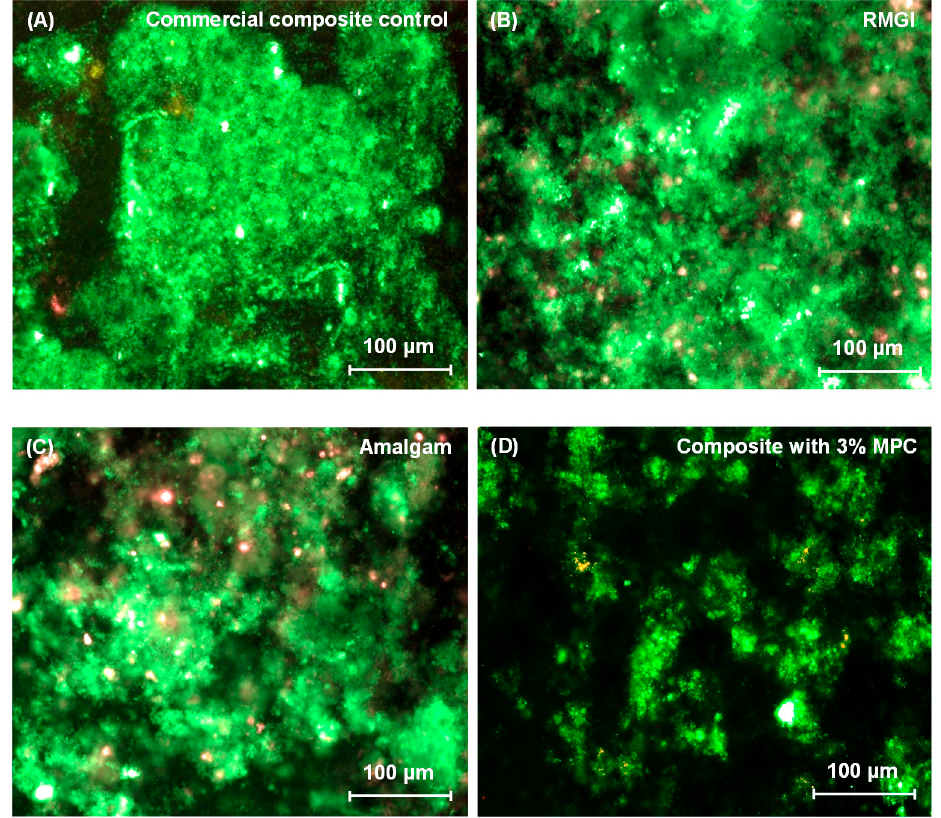
Figure 2. Representative live/dead staining images of dental plaque microcosm biofilms grown for two days on disks: ( A ) Commercial composite control; ( B ) RMGI; ( C ) Amalgam; and ( D ) Composite with 3% MPC. The composite control with 0% MPC had biofilms similar to ( A ) and was not included in Figure 2. Live bacteria were stained green, and dead bacteria were stained red.